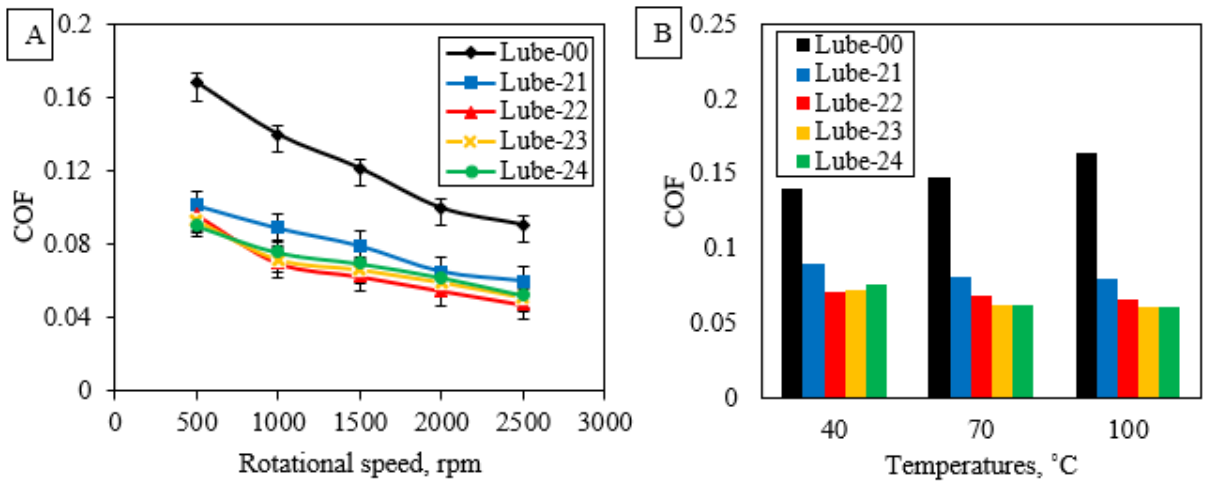
Figure 4. Coefficient of friction of hybrid nano lubricant samples with different loading levels of 0.5 to 2 wt% Al 2 O 3 NPs and 1.0 wt% MWCNTs ( A ) at different velocities and ( B ) at different temperatures.